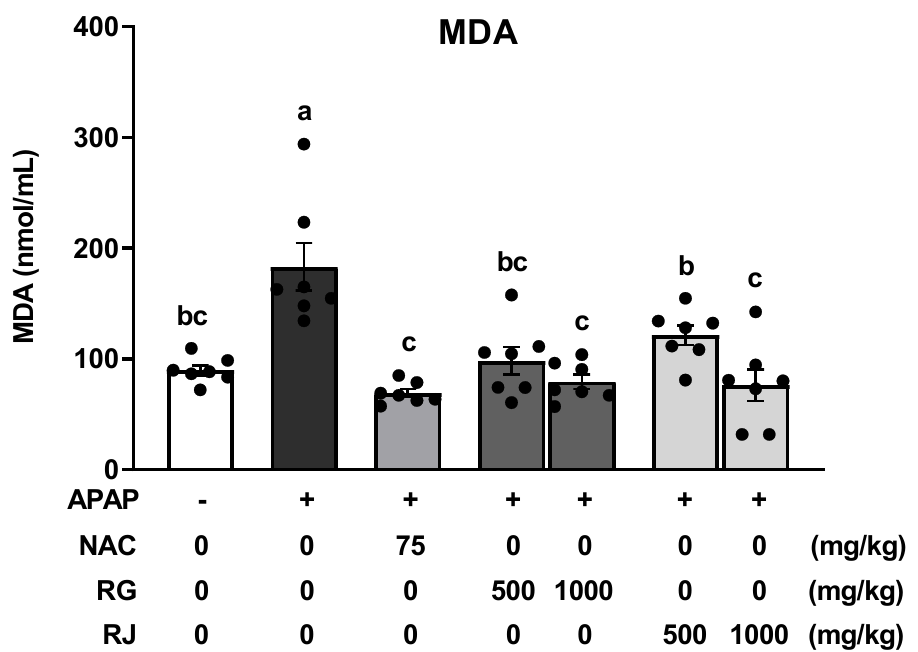
Figure 5. Effects of radish extracts on plasma lipid peroxidase activity in the APAP-induced liver- damaged mice. Malondialdehyde (MDA) production was measured using an ELISA kit. Results are presented as means ± SE. Different letters represent groups that are significantly different from each other using ANOVA at p < 0.05 ( n = 7). Each dot indicates data measurement for one mouse. CTRL, control; NAC, N-acetyl cysteine; RG, turnips of Ganghwa; RJ, radishes of Jeju.